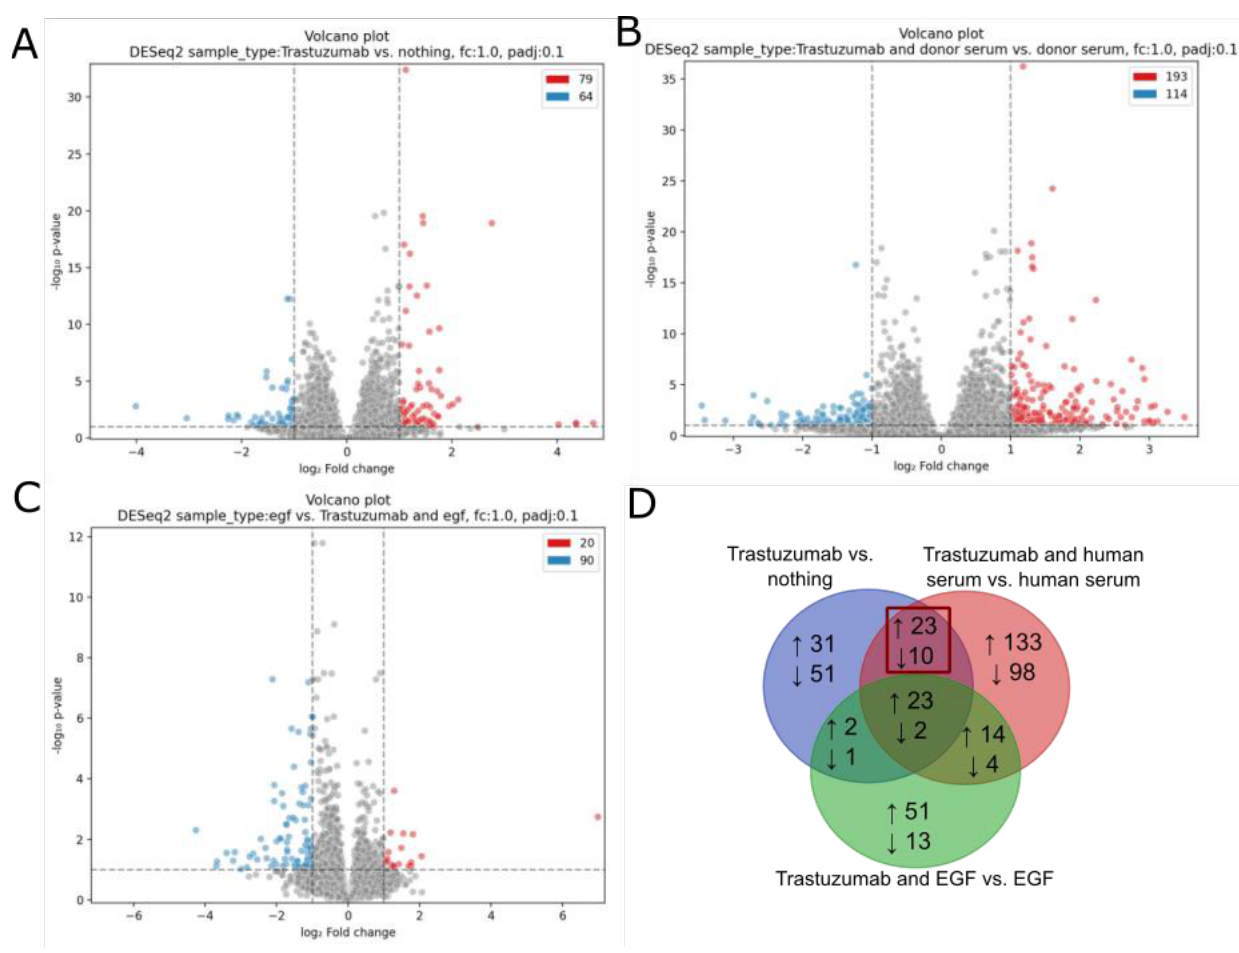
Figure 8. Differentially expressed genes in the comparisons ( A ) Trastuzumab vs. FBS (nothing); ( B ) Trastuzumab and donor serum vs. donor serum; and ( C ) EGF vs. Trastuzumab and EGF. Upregu- lated genes are shown in red (log2FC > 1, adjusted p -value < 0.1), downregulated genes are shown in blue (log2FC < −1 , adjusted p -value < 0.1). ( D ) Intersection of the differentially expressed genes